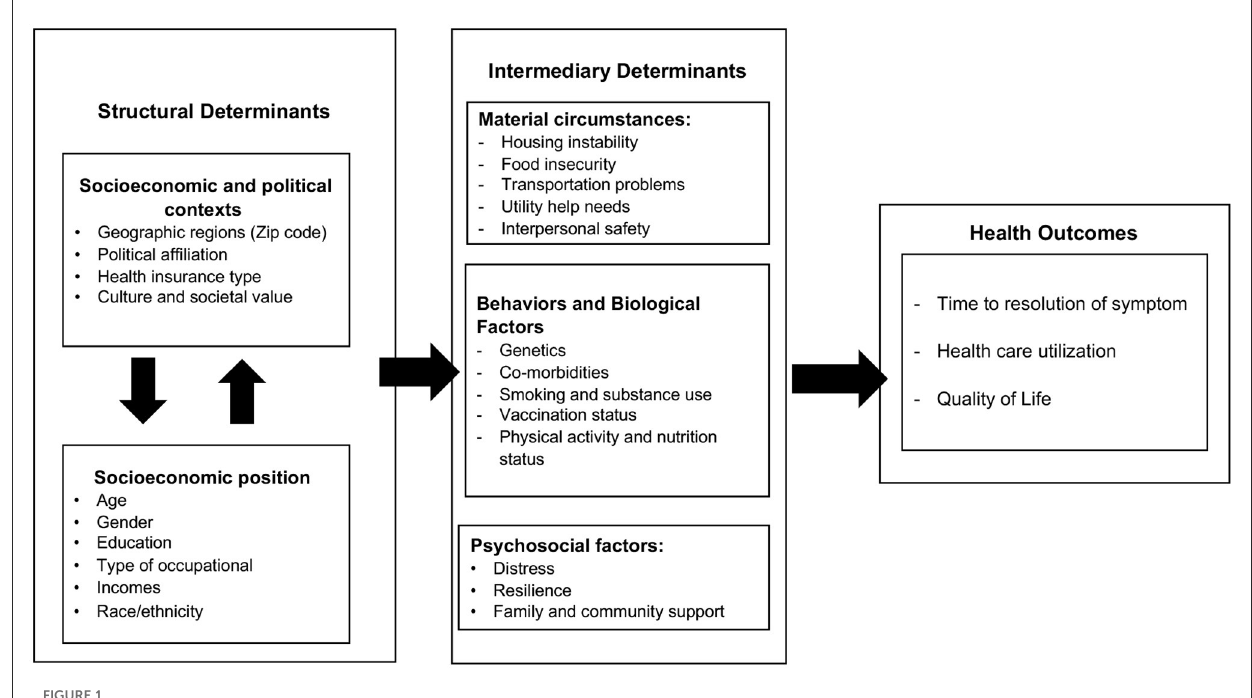
FIGURE1 Long COVID health outcomes in the context of social